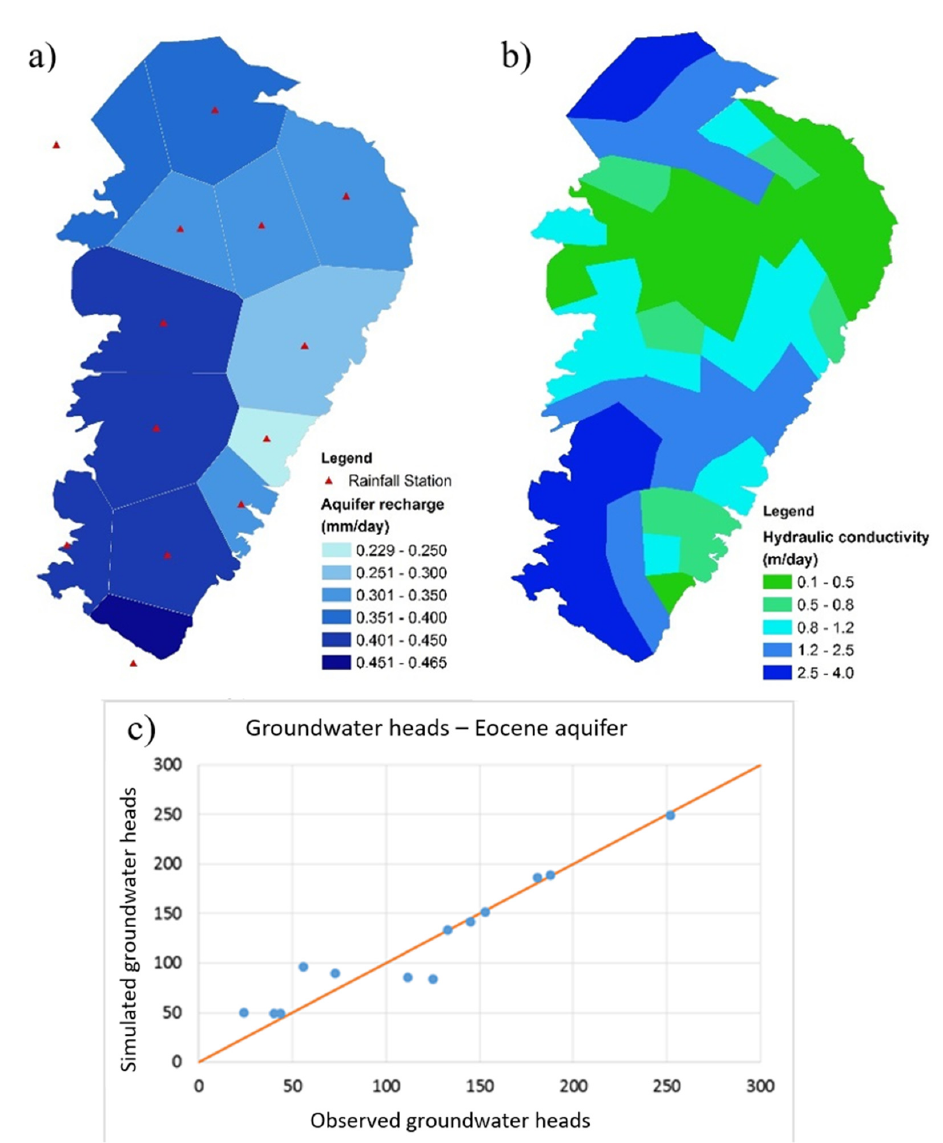
Figure 6. Modelled aquifer recharge ( a ), hydraulic conductivity ( b ), and calibration results ( c ).